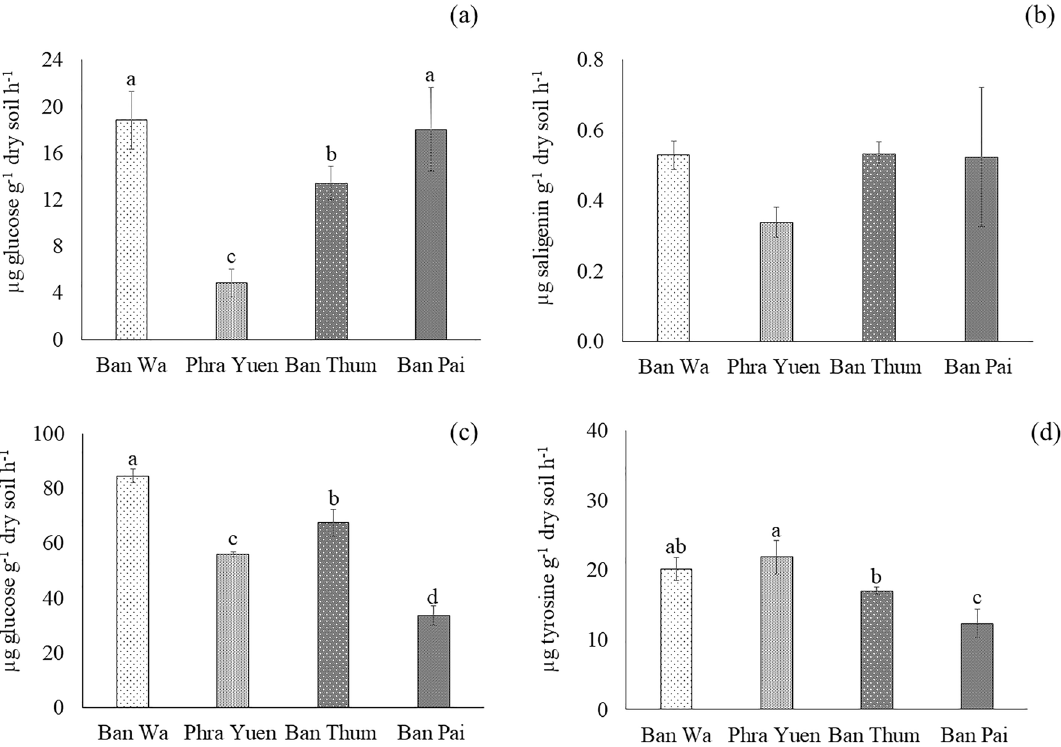
Figure 1. Enzyme activities in rhizosphere soils of ‘RD6’ rice grown in saline rice fields located in four areas in Khon Kaen province, Thailand. ( a cellulase, b β-glucosidase, c invertase, d : protease). Different letters represent significant differences at p < 0.05 according to LSD